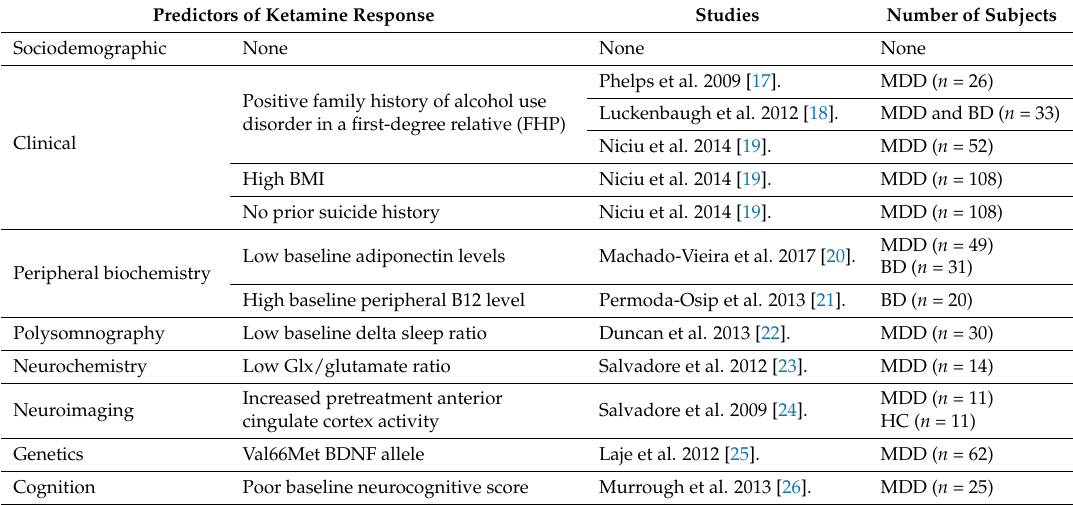
Table 1. Predictors of ketamine